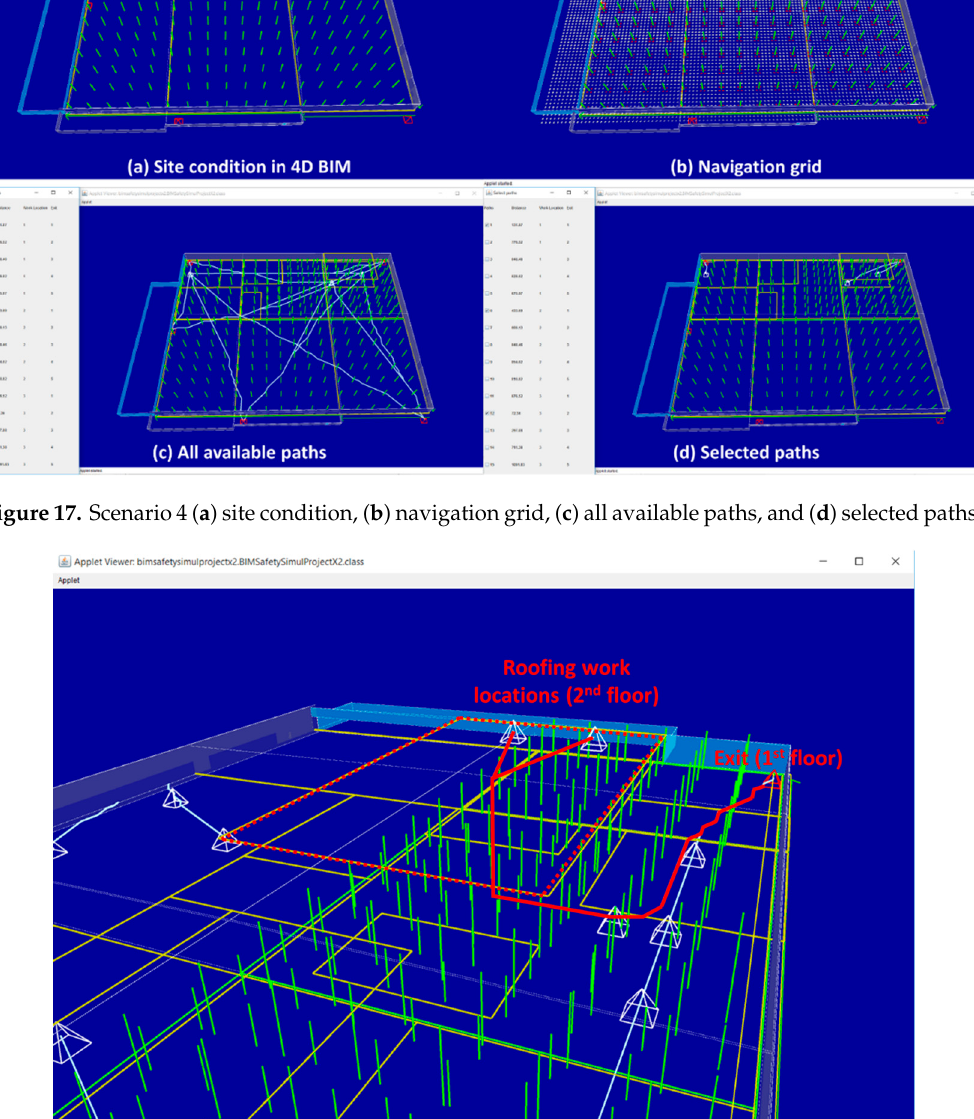
Figure 16. Evaluation paths from roofing work locations in scenario 2. Figure 18. Evaluation paths from roofing work locations in scenario